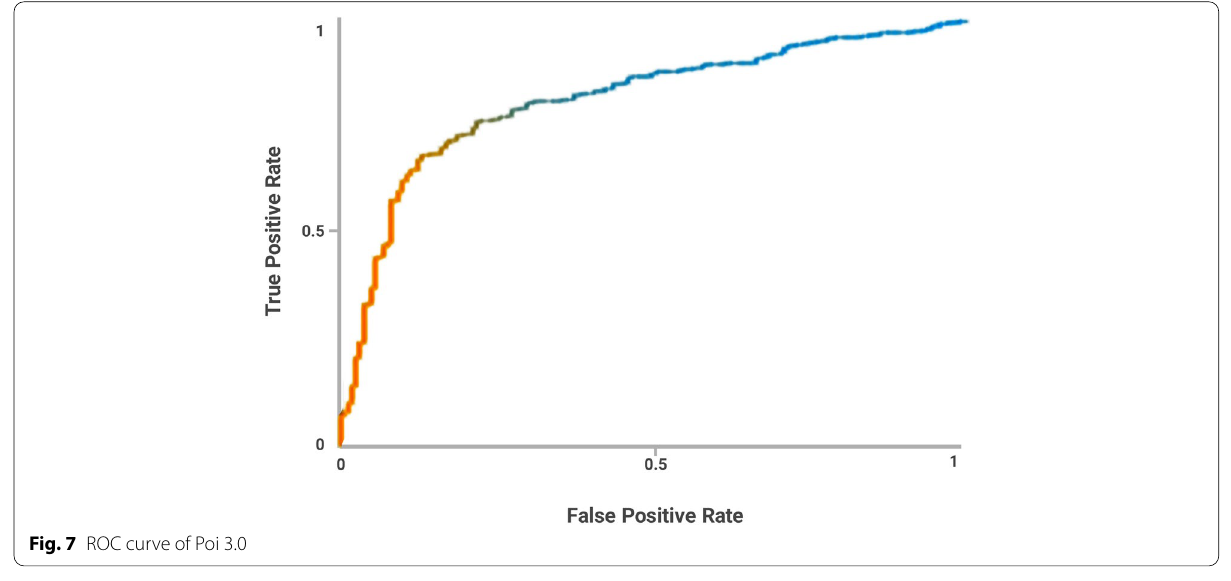
Fig. 7 ROC curve of Poi 3.0